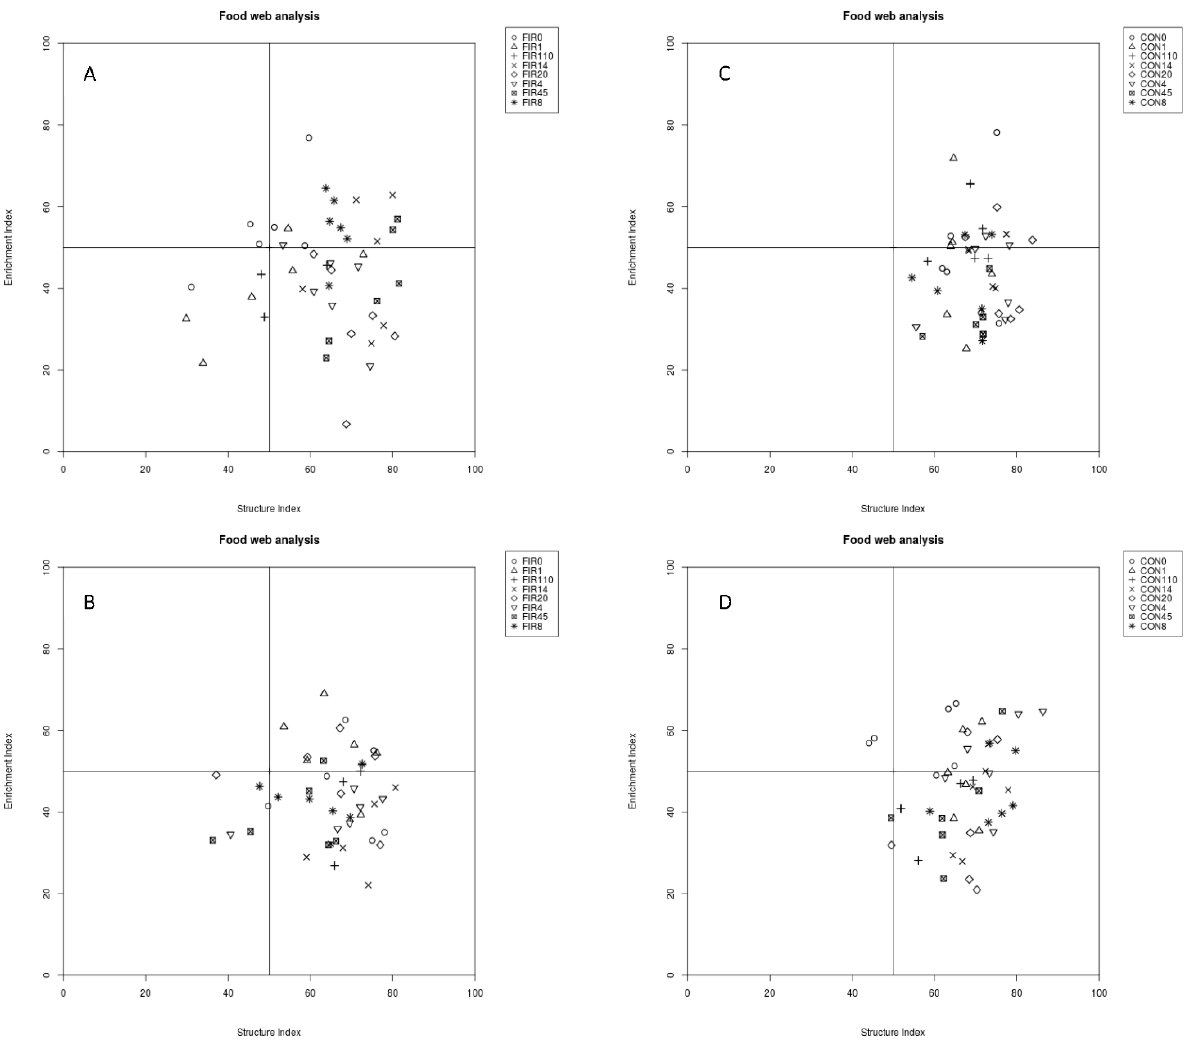
Figure 1. Nematode weighted faunal analysis profiles (see text and Ferris et al. (2001)): status (recovery) of soil nematode communities in chronosequence 0–110 y post-fire depending on fire severity (( A ), high; ( B ), low; ( C , D ) related control plots) along axes of structure (SI) and enrichment